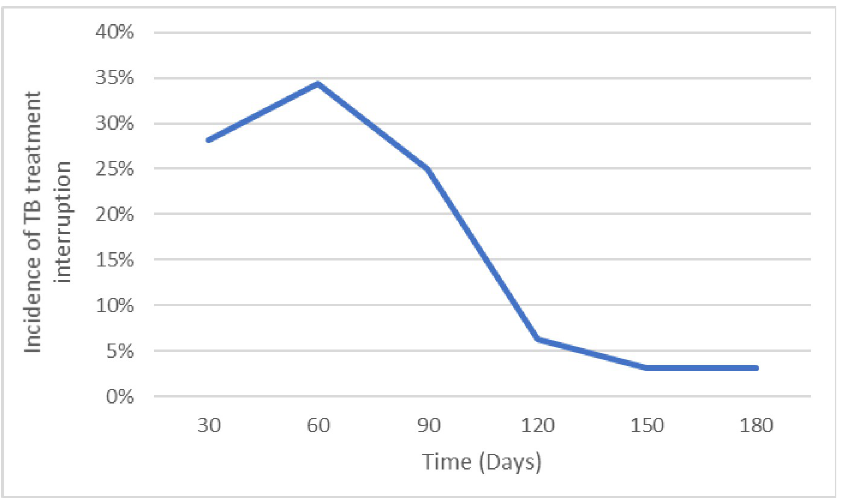
Fig 1. Incidence of TB treatment interruption by